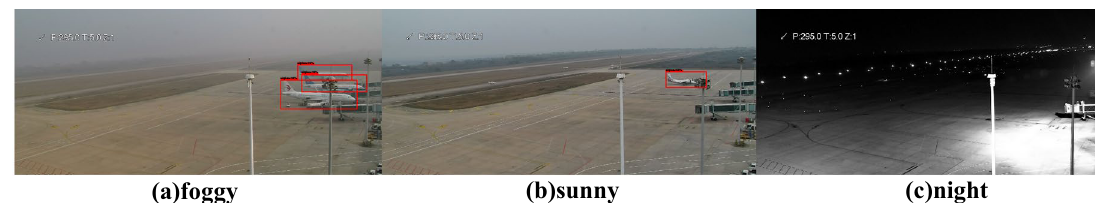
Figure 8. SSD detection renderings in different scenarios.